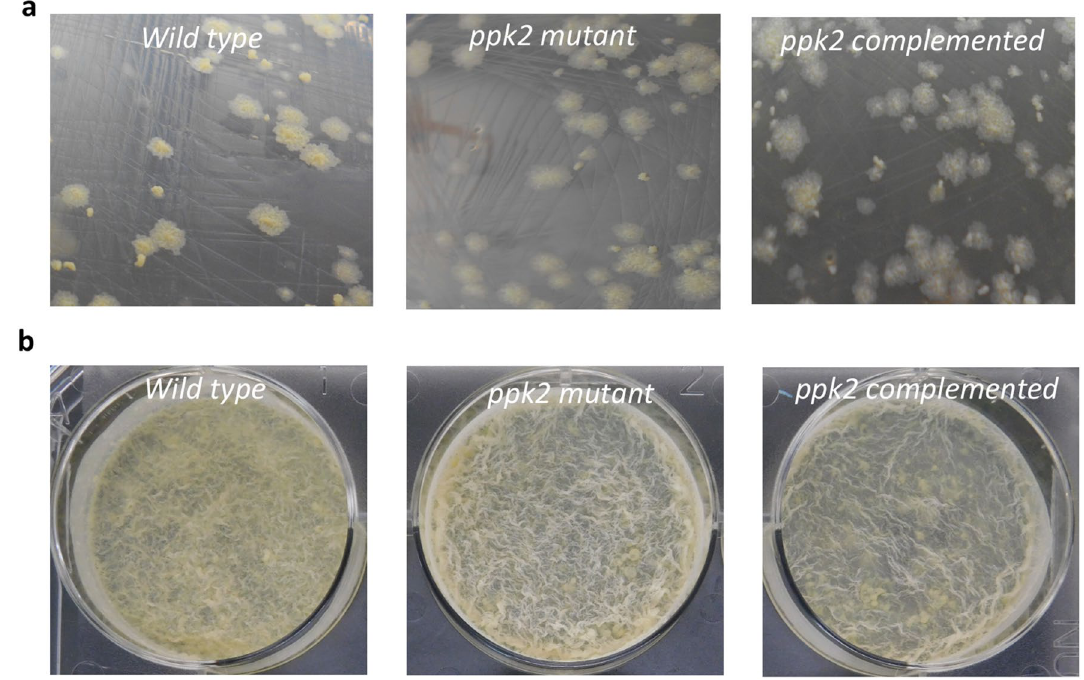
Supplementary Fig. 2. Effect of PPK-2 deletion on colony morphology (A) and biofilm formation (B) of M. tuberculosis . (A) Colony morphology of various M. tuberculosis strains was determined by plating 10-fold serial dilutions on MB-7H11 plates. (B) Biofilm images of the standing cultures of wild type, ppk-2 mutant and ppk-2 complemented strains in polystyrene coated 6-well plates in Sauton’s medium. The images depicted are representative of two independent